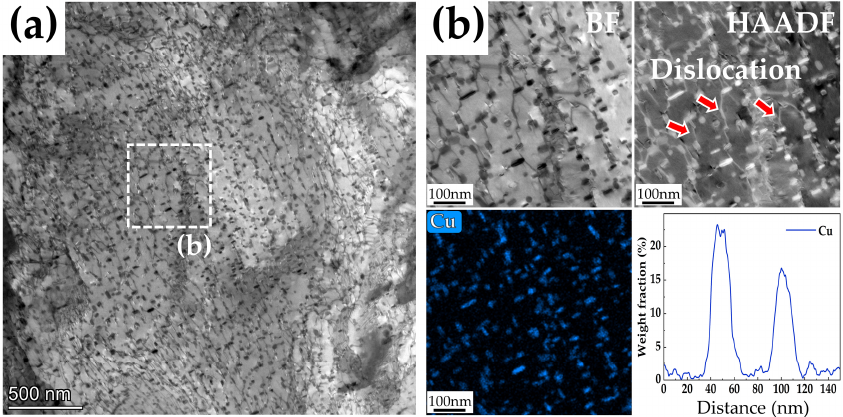
Figure 12. ( a ) Bright field TEM image of a 3Cu ‐ steel tempered at 600 °C. ( b ) STEM images corresponding to the white region in ( a ).